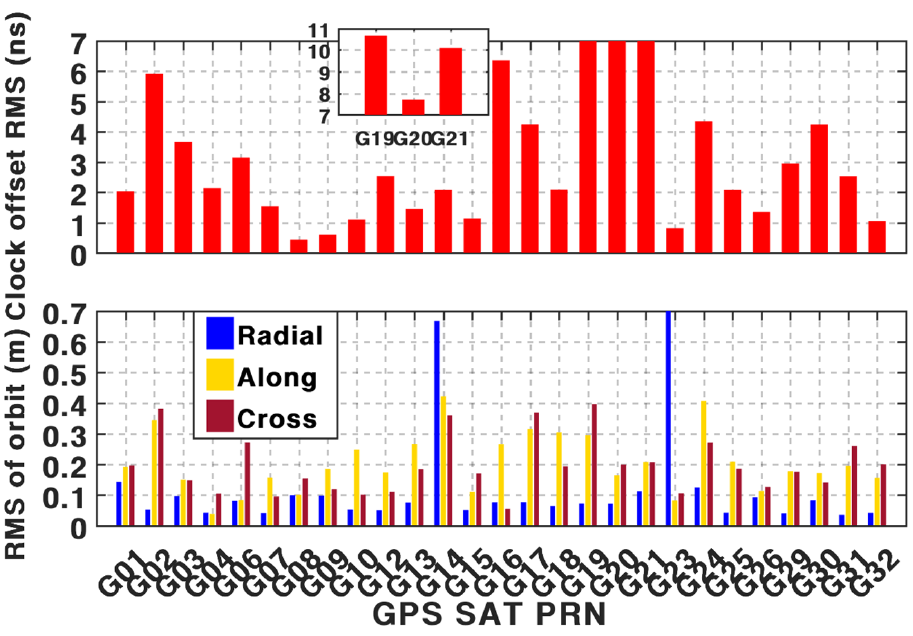
Figure 4. RMS of GPS clock offset, and orbit errors of real-time products recovered by PPP-B2b service.